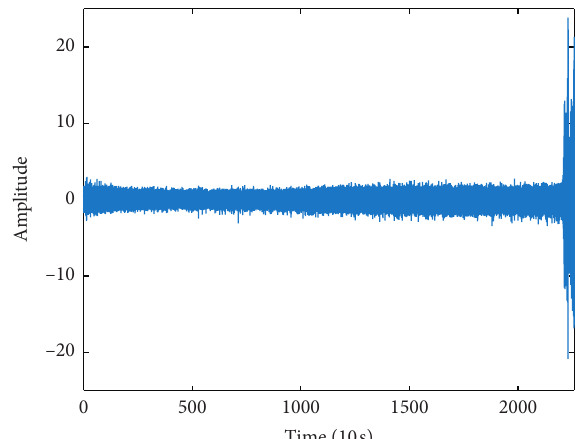
Figure 12: Vibration signal of bearing 1_7.